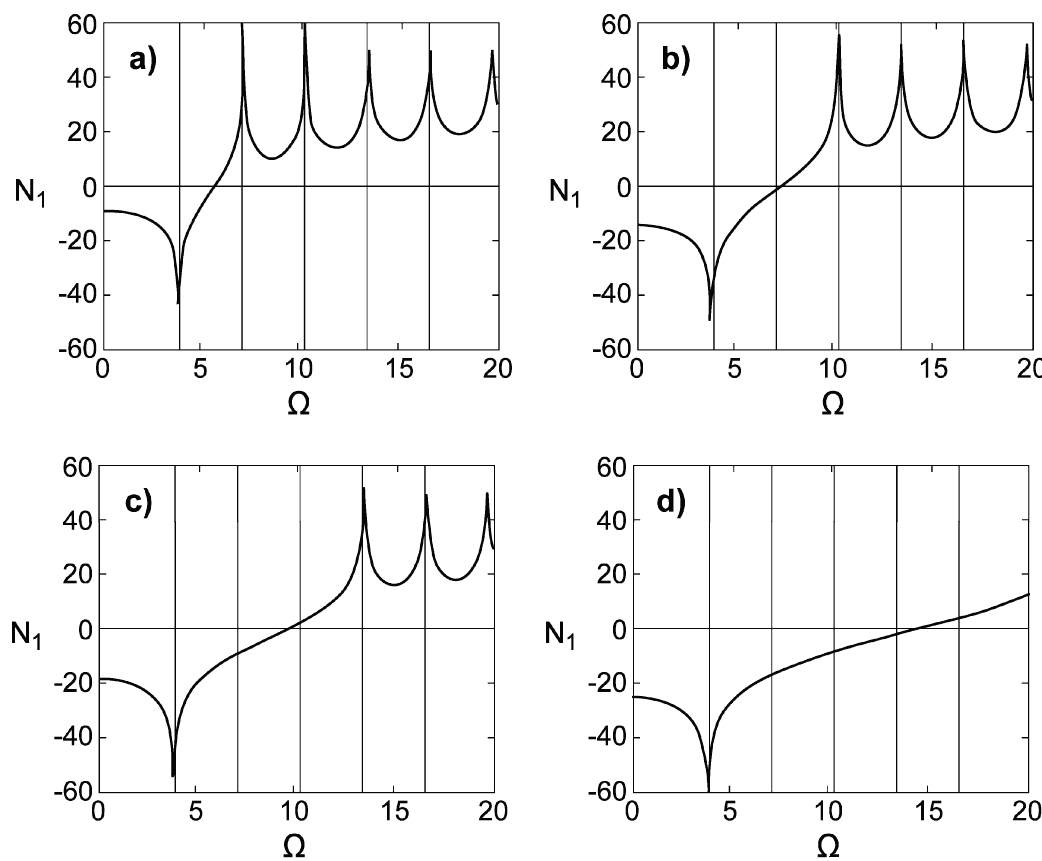
Figure 15. Active noise reduction in a cylindrical duct. Active noise reduction uses anti-noise sources or loudspeakers to cancel the existing noise field. Similarly active vibration suppression uses actuators to cancel existing vibrations. In both cases cancellation is achieved by generating a signal with the same amplitude and opposite phase. There are two paths for noise transmission: (i) the aerial path of sound waves that can be countered by active noise suppression; (ii) the structural path of vibrations that radiate sound can be countered by active vibration suppression. Examples of (i) include active noise reduction in an aircraft cabin, and of (ii) active suppression of the vibration of guide vanes in a jet engine. Another example of (ii) is suppression of vibration modes of a helicopter